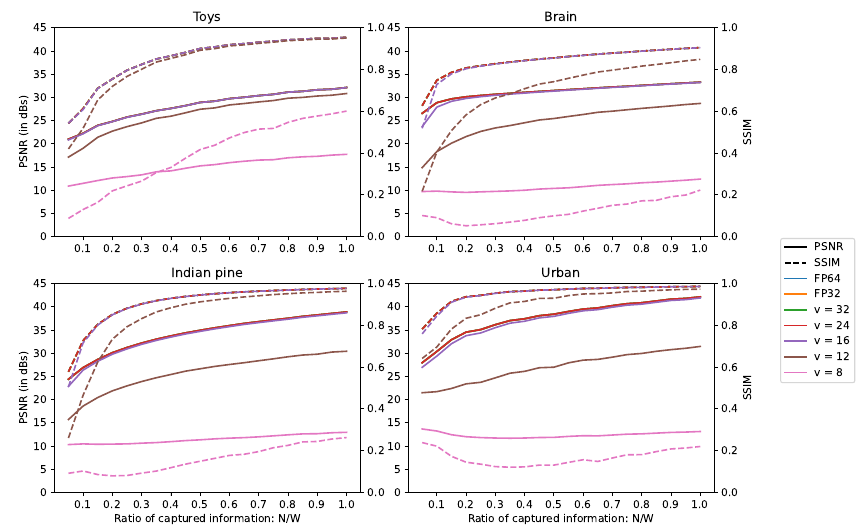
Figure 8. PSNR and SSIM depending on the quantity of captured information and data encoding. FP64 and FP32 denote, respectively, 64- and 32-bit floating-point data encoding; v is the number of bits of the the fixed-point’s fractional part.